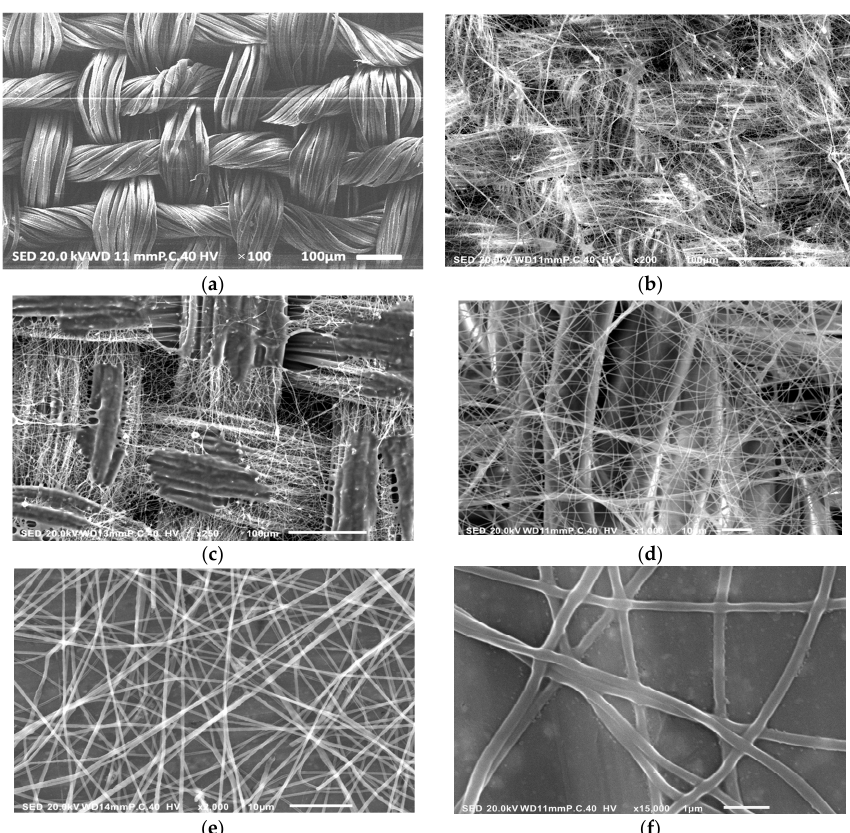
Figure 6. The morphology of ( a ) silk fabric, ( b ) temperature- and pH-sensitivity mulberry silk fabric (×200), ( c ) temperature- and pH-sensitivity mulberry silk fabric (×250), ( d ) temperature- and pH-sensitivity mulberry silk fabric (×1000), ( e ) PNIPAAm/chitosan/PEO nanofibers (×1000), and ( f ) PNIPAAm/chitosan/PEO nanofibers (×15,000).